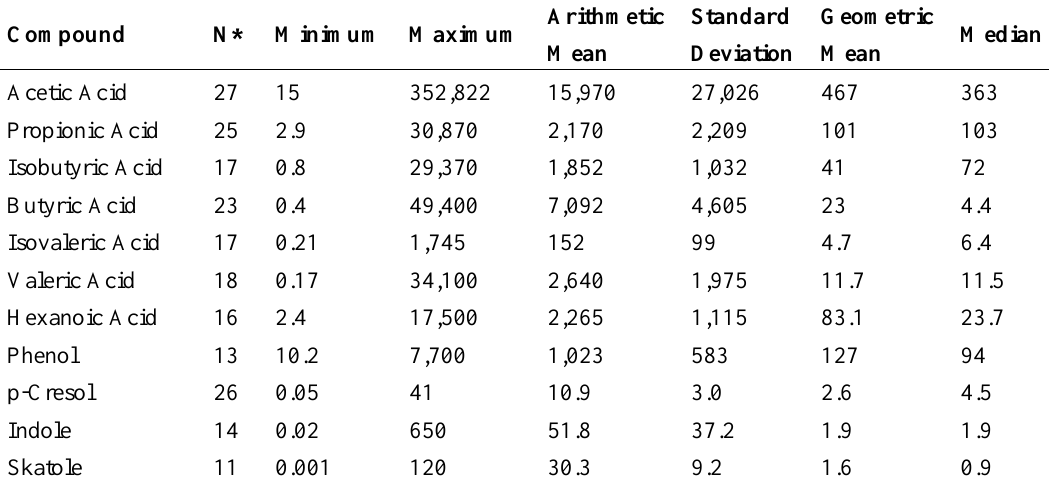
Table 2. A statistical summary of published single-compound odor thresholds (SCOT) for seven volatile fatty acids and four aromatic compounds (µg m −3